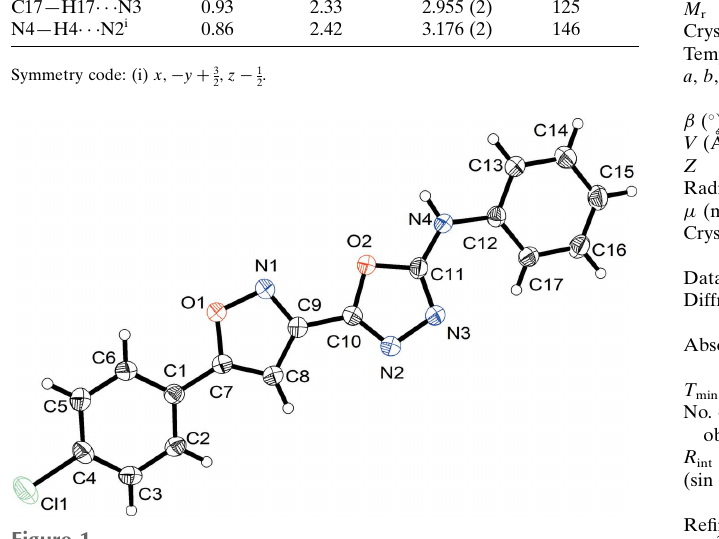
Table 2 Experimental details. Crystal data Chemical formula